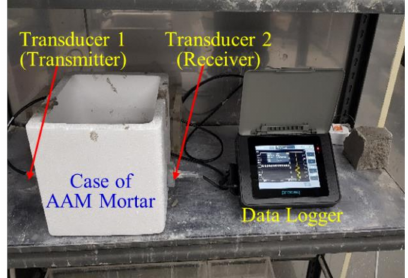
Figure 1. Schematic of ultrasonic pulse velocity (UPV) monitoring.